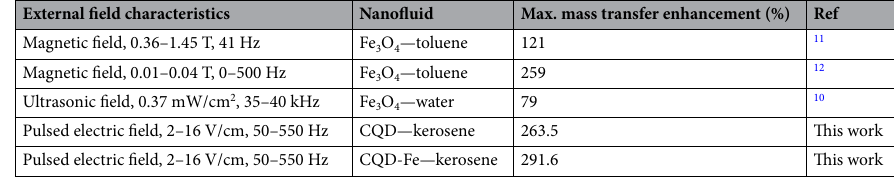
Table 5. Comparison of the impact of different external fields on the mass transfer intensification of circulating